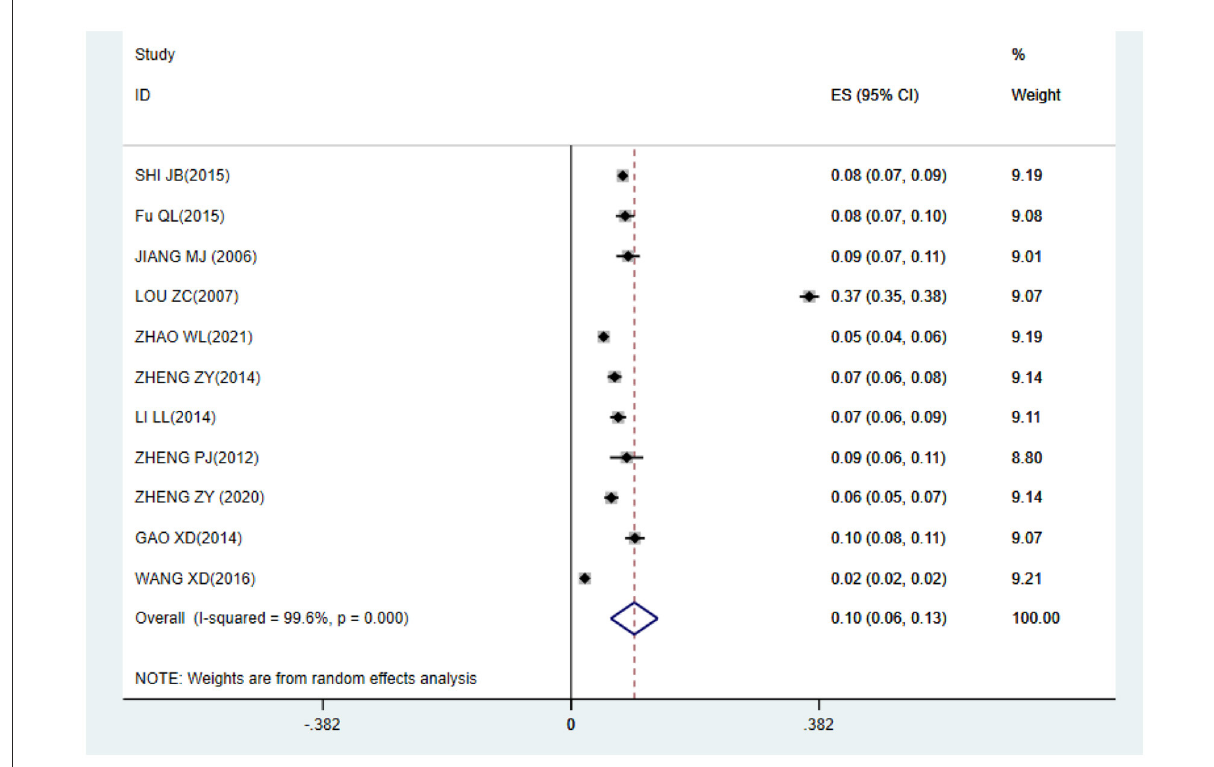
FIGURE2 The forest plot of the overall prevalence of CRS among